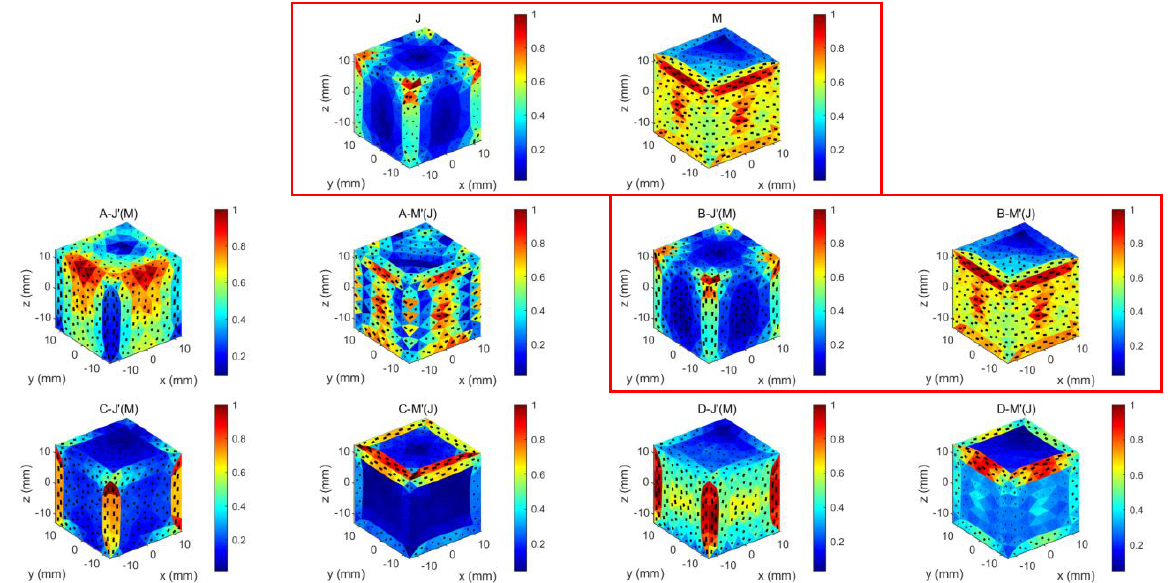
Figure 4. Comparison of characteristic electric and magnetic current distributions (J, M) of mode 1 (spurious mode) obtained from Equation (19) at 2.0 GHz, with other corresponding currents (J’(M), M’(J)) generated by submitting (M, J) into boundary conditions of problems (A), (B), (C) and (D).